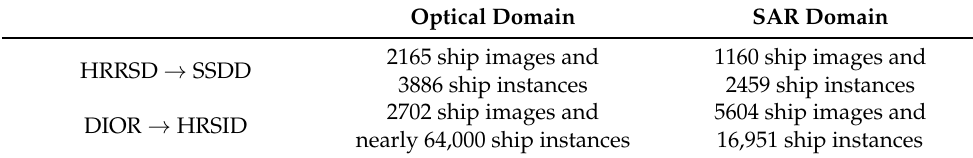
Table 1. Statistics of two cross-domain